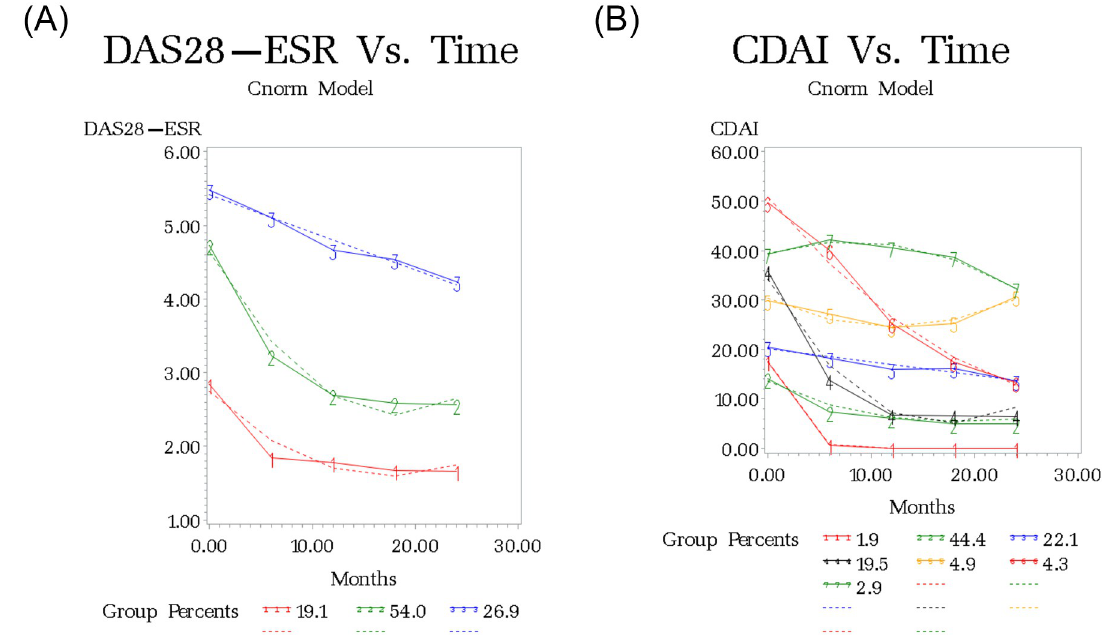
Fig 2. Observed and fitted trajectories from latent growth curve analysis for disease course over 2 years in patients with early RA. A. DAS28-ESR. DAS28-ESR category : Remission: DAS-ESR < = 2.6; LDA: DAS-ESR < = 3.2; Moderate: 3.2 < DAS28-ESR < = 5.0; Severe: DAS28-ESR > 5.0. B. CDAI. CDAI category : Remission (REM): CDAI < = 2.8; LDA: CDA < = 10; Moderate (MD): 10 < CDAI < = 22; Severe (HD): CDAI > 22. Dashed line: fitted values. Solid line: observed values.